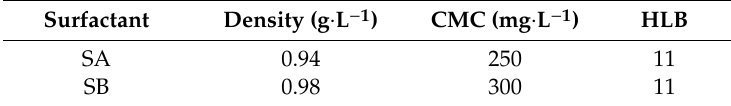
Table 4. Density, critical micelle concentration (CMC), and hydrophilic–lipophilic balance (HLB) for